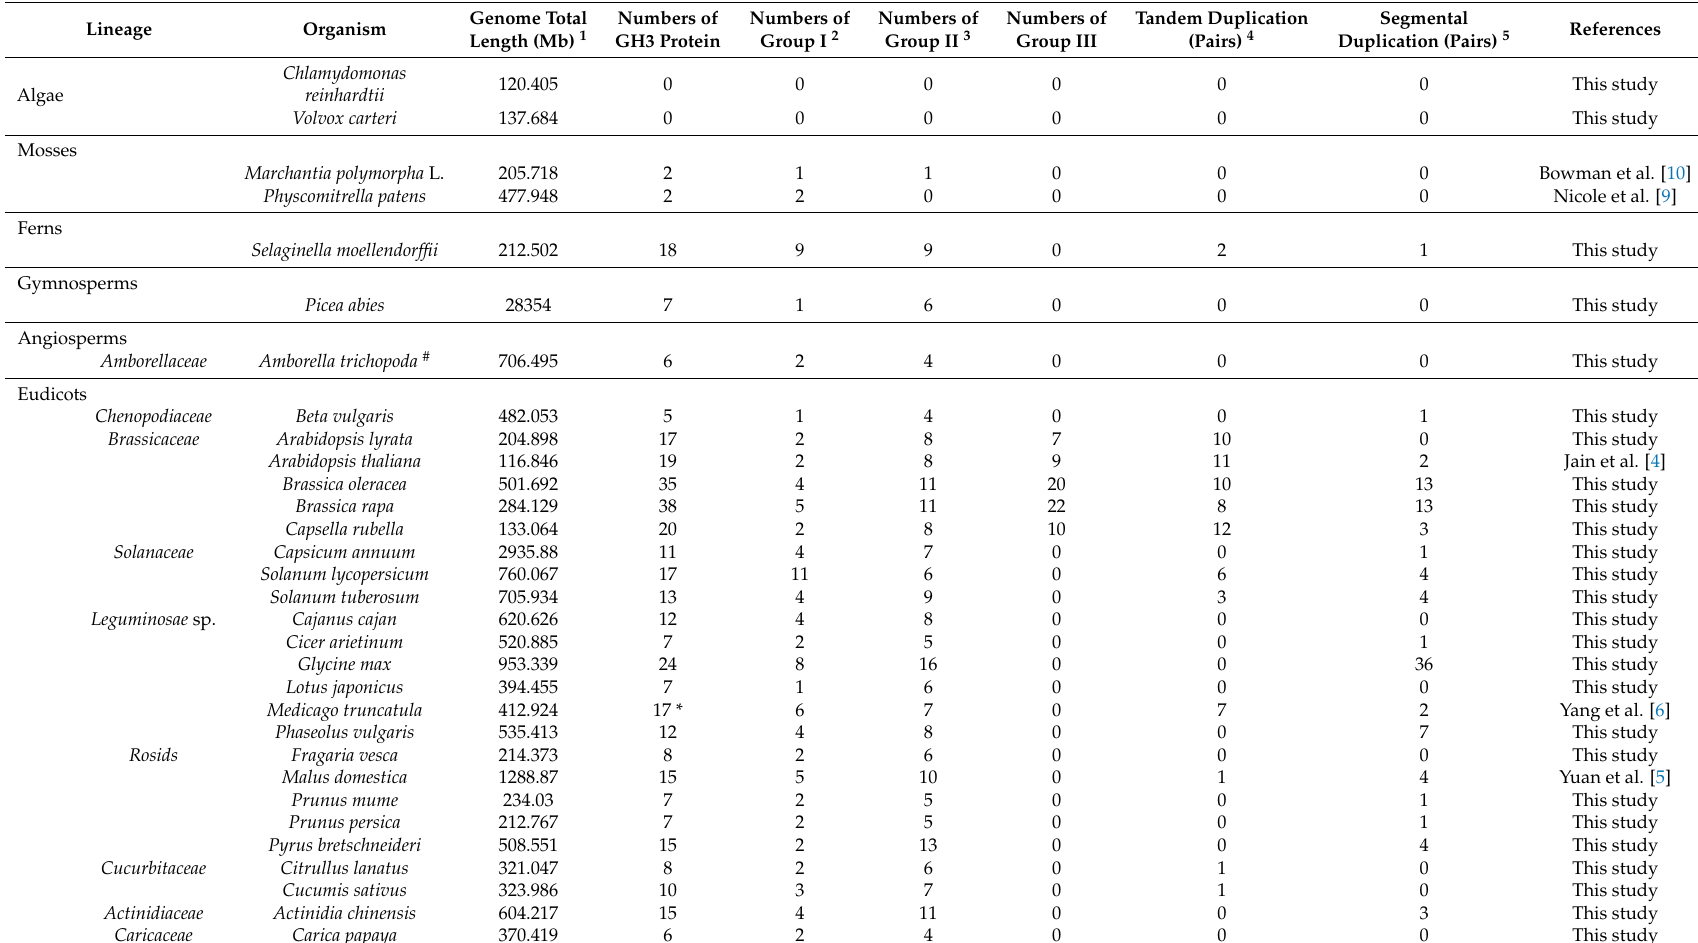
Table 1. Glycoside Hydrolase 3 ( GH3 ) genes identified in 48 sequenced plant